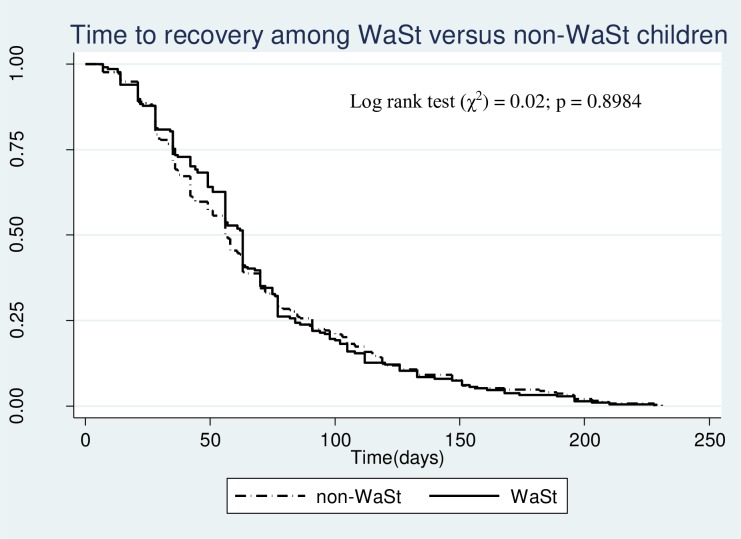
Comparison of Kaplan Meier survival curves of WaSt vs. non-WaSt children among children who recovered from SAM in OTC, Karamoja.